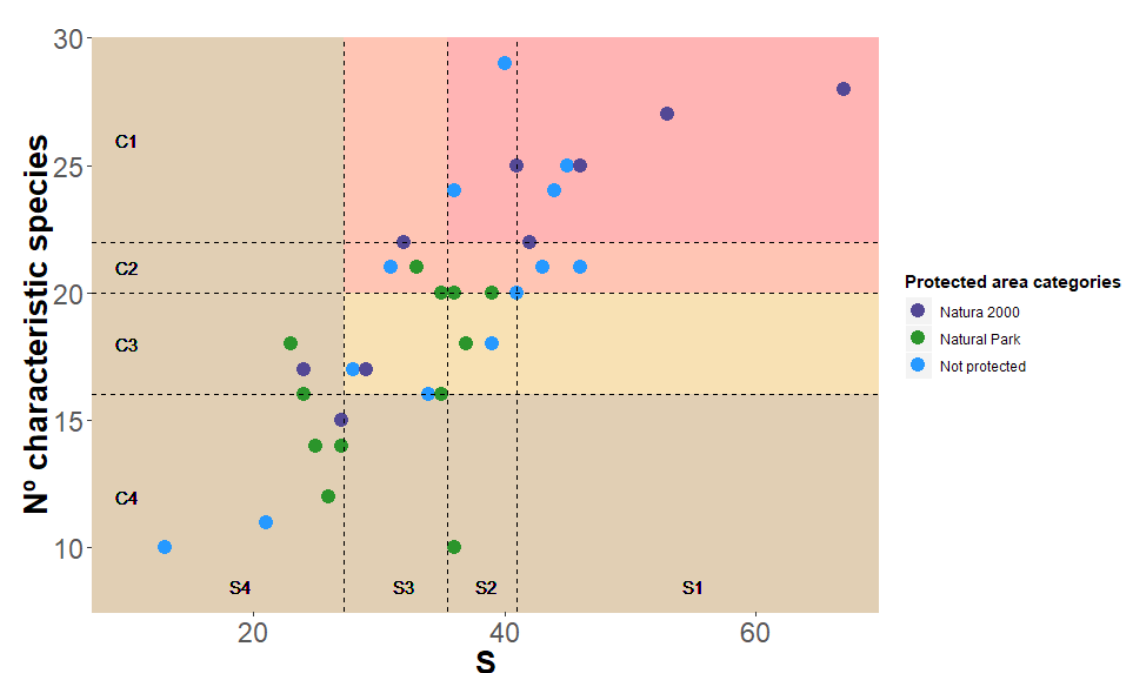
Figure 4. Prioritization system for conserving sessile oak forests on the NE Iberian Peninsula using two key conservation indicators: the number of characteristic species (Y axis) and the species richness (X axis); the quartiles are shown on each corresponding axis. The background colors depict the level of prioritization, with dark red being the top category, lighter red the second level, orange the third level, and brown the fourth. The points are the sessile oak inventories, with different colors corresponding to each protected area